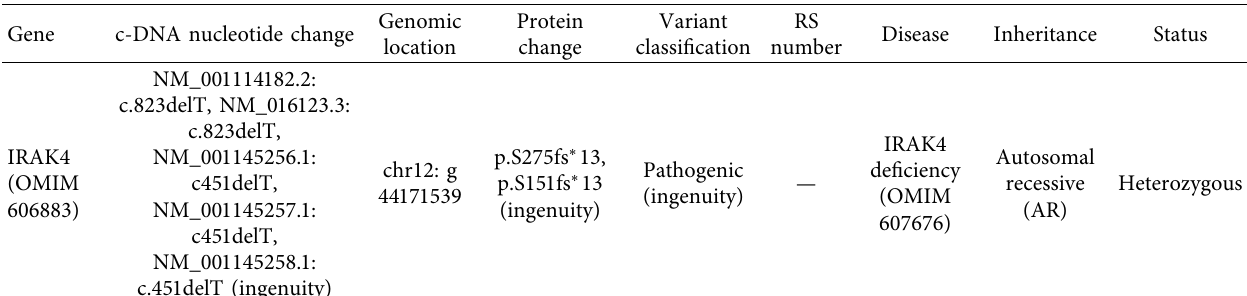
Table 3: Whole exome sequencing